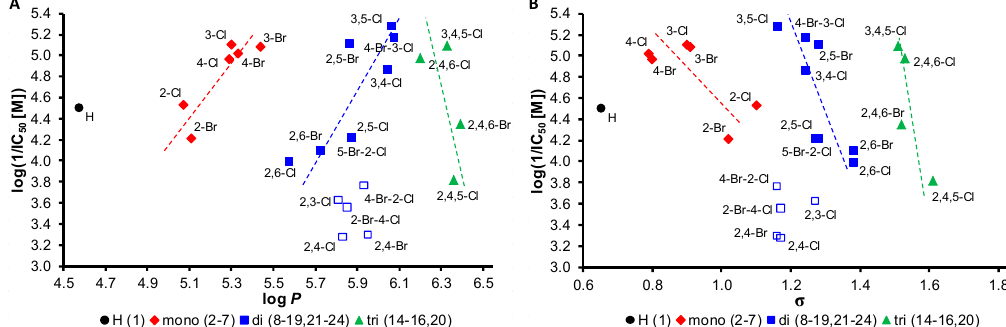
Figure 1. Dependence of PET-inhibiting activity log(1/IC 50 [M]) of all discussed compounds 1 – 24 in spinach chloroplasts on lipophilicity expressed as log P ( A ) and electronic σ parameters of whole N -aryl part of individual anilides ( B ). Empty squares are not involved in SAR